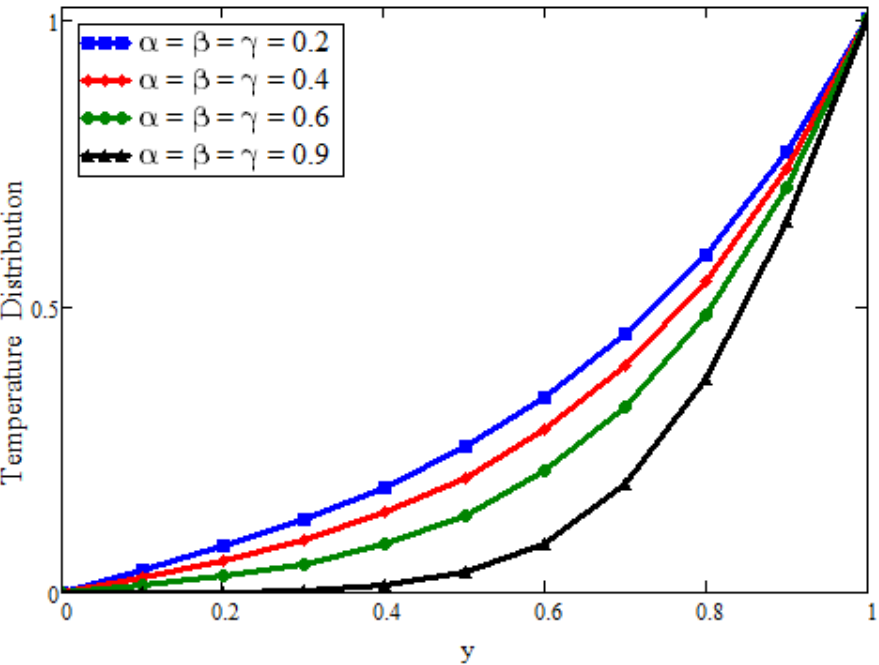
Figure 4. Temperature distribution against y due to fractional parameters α , β , γ for small time, when t = 0.1 , Pr = 6.2, φ hnf = 0.02.